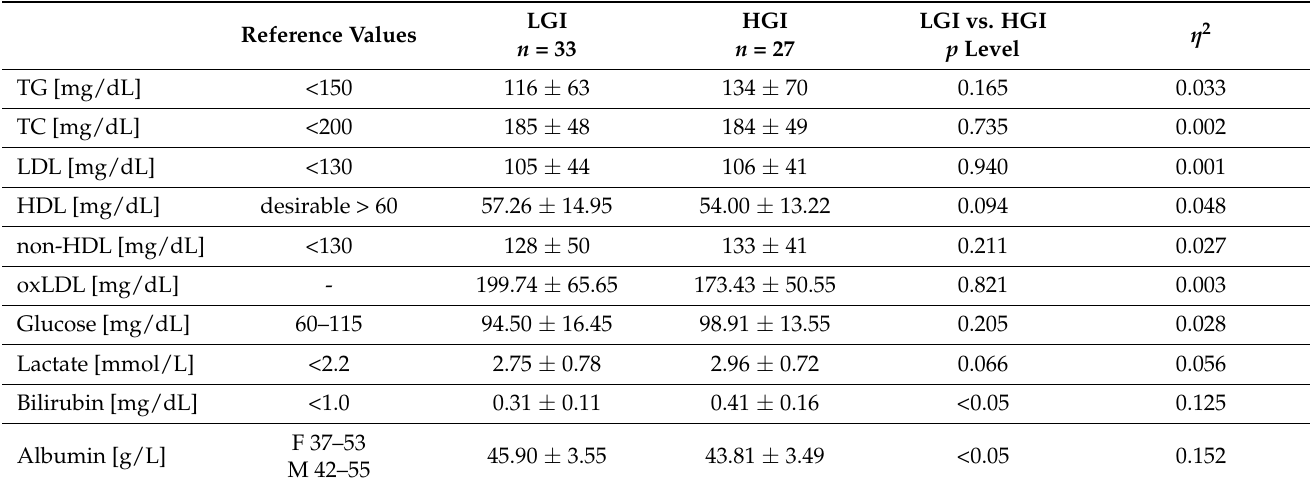
Table 5. Lipoprotein-lipid profile and other biochemical variables (mean ±